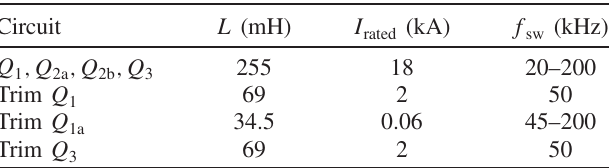
TABLE IV. The inductance L , the nominal current I switching frequency f consideration [44,46].